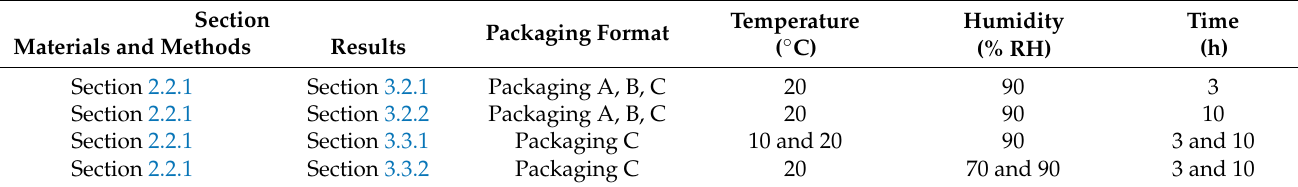
Table 1. Experimental design of simulated